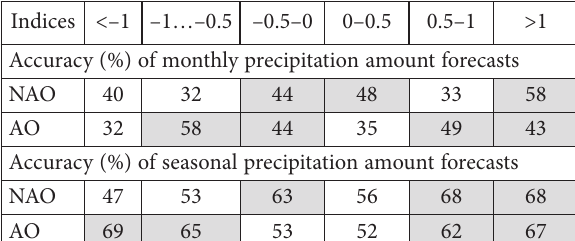
for the initialization of monthly and seasonal long-range precipitation amount forecasts for the territory of Lithuania using CFSv2. Indices leading to better-than-average accuracy (average fractions of the correct forecasts are 42% for monthly and 61% for seasonal forecasts) are depicted in light